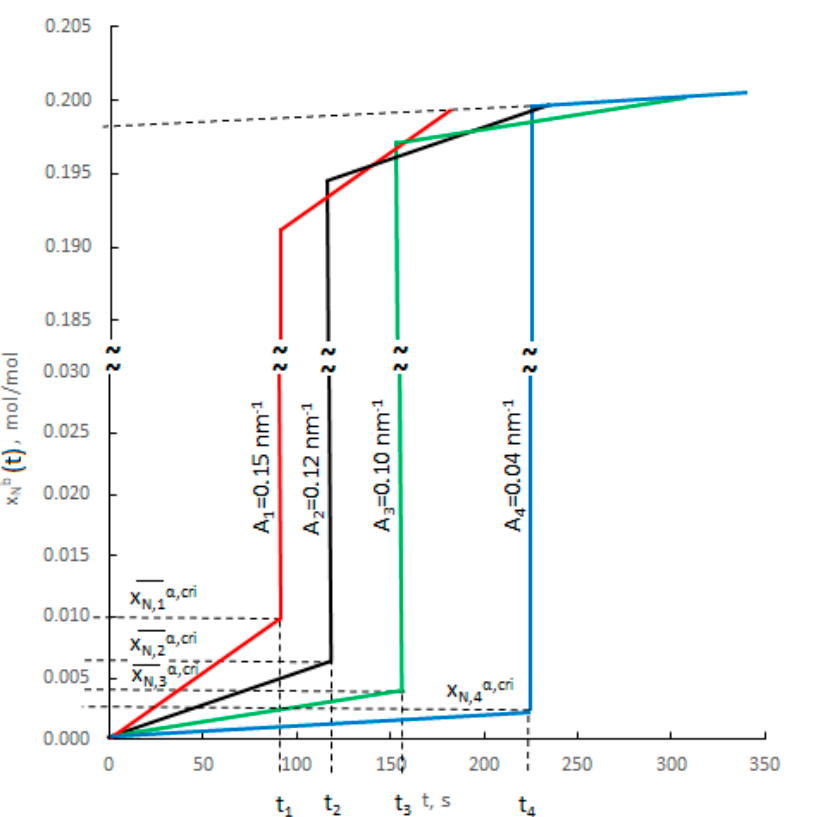
Figure 6. Changes in nitrogen concentration over time for nanocrystallites with active specific surfaces in the range 0.04–0.15 nm − 1 .